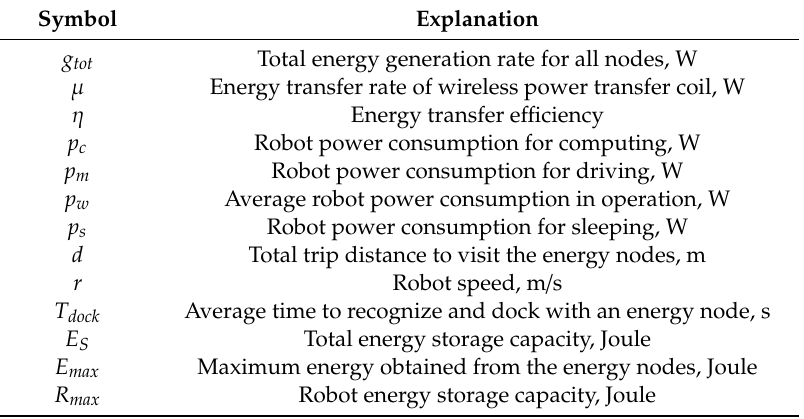
Table 1. Symbols used in the charge model.